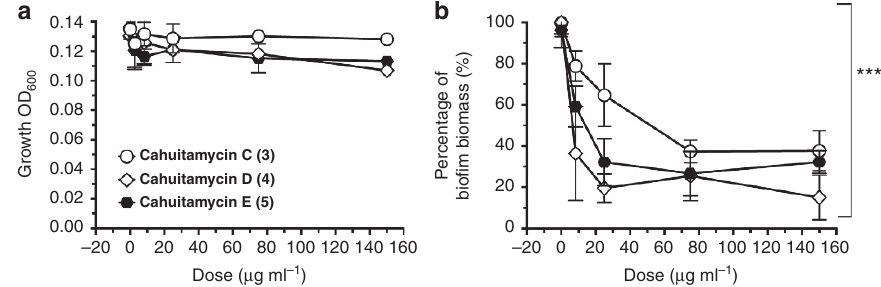
Figure 6 | Biological activity of cahuitamycins C–E (3–5). ( a ) Growth of A. baumannii and ( b ) inhibition of biofilm in the presence of cahuitamycins C–E ( 3 – 5 ). Results are the average of three replicates ± s.d. Student’s t -test was used for statistical analysis. *** P o 0.001 compared with control (no addition of